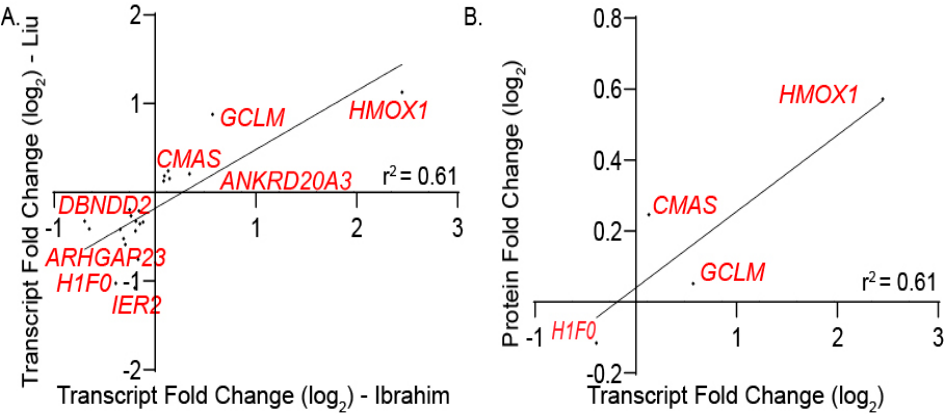
Figure 6. Defining common NRF3 targets within transcriptomes and proteomes. ( A ) Plot depicting the linear relationship of differentially expressed transcripts derived from the common NRF3 targets in this work and from Liu et al. ( B ) Linear regression plot of log 2 fold change values of protein and transcript levels of significantly modulated genes in response to NRF1 overexpression.